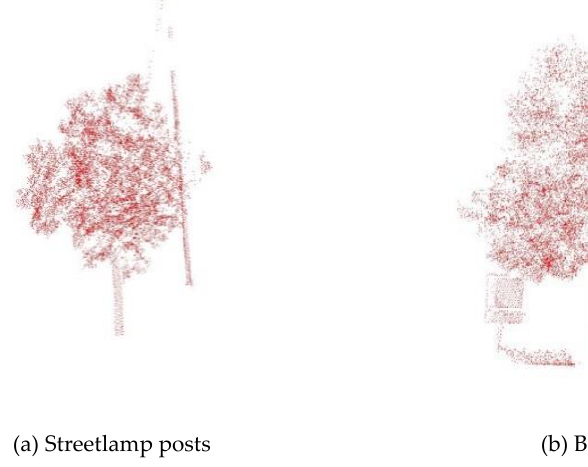
Figure 14. Bad extraction of infrastructure points.